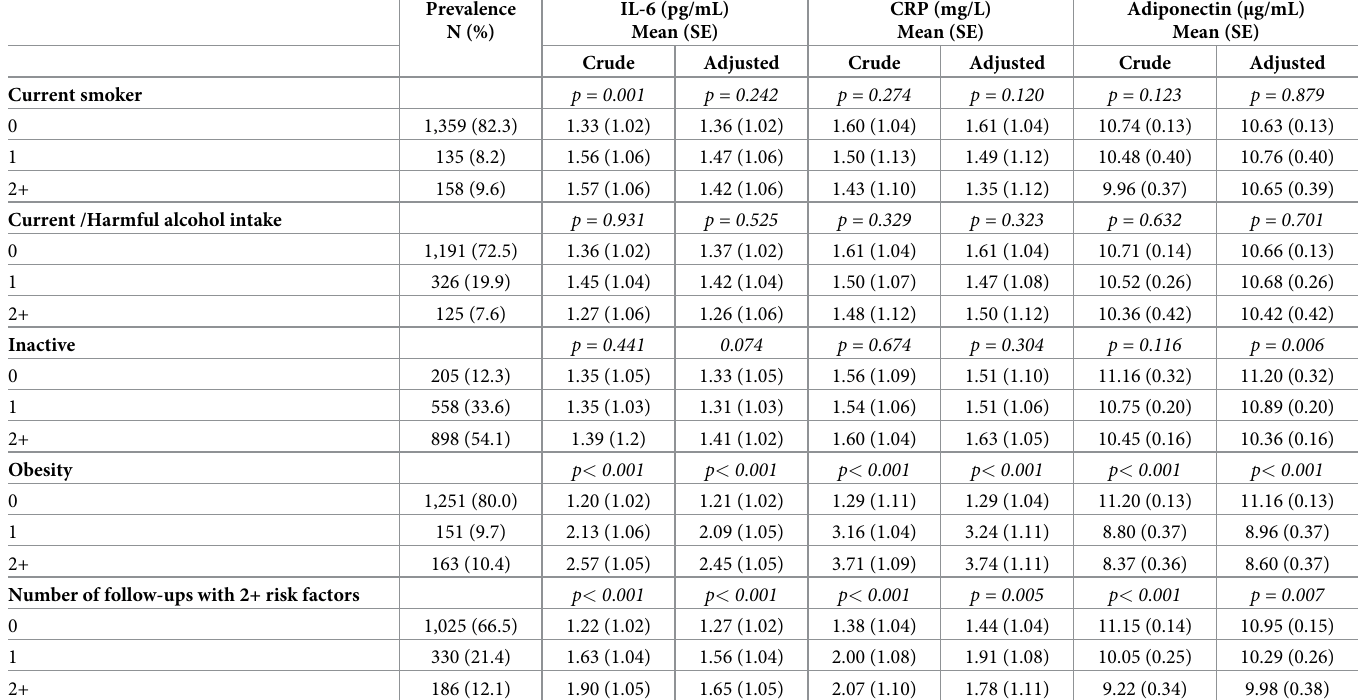
Table 3. Crude and adjusted linear regressions between number of follow-ups, from 15 to 22 years, presenting the exposure and IL-6, CRP and adiponectin at 22 years old, females (n = 1,819). The 1993 Pelotas Birth